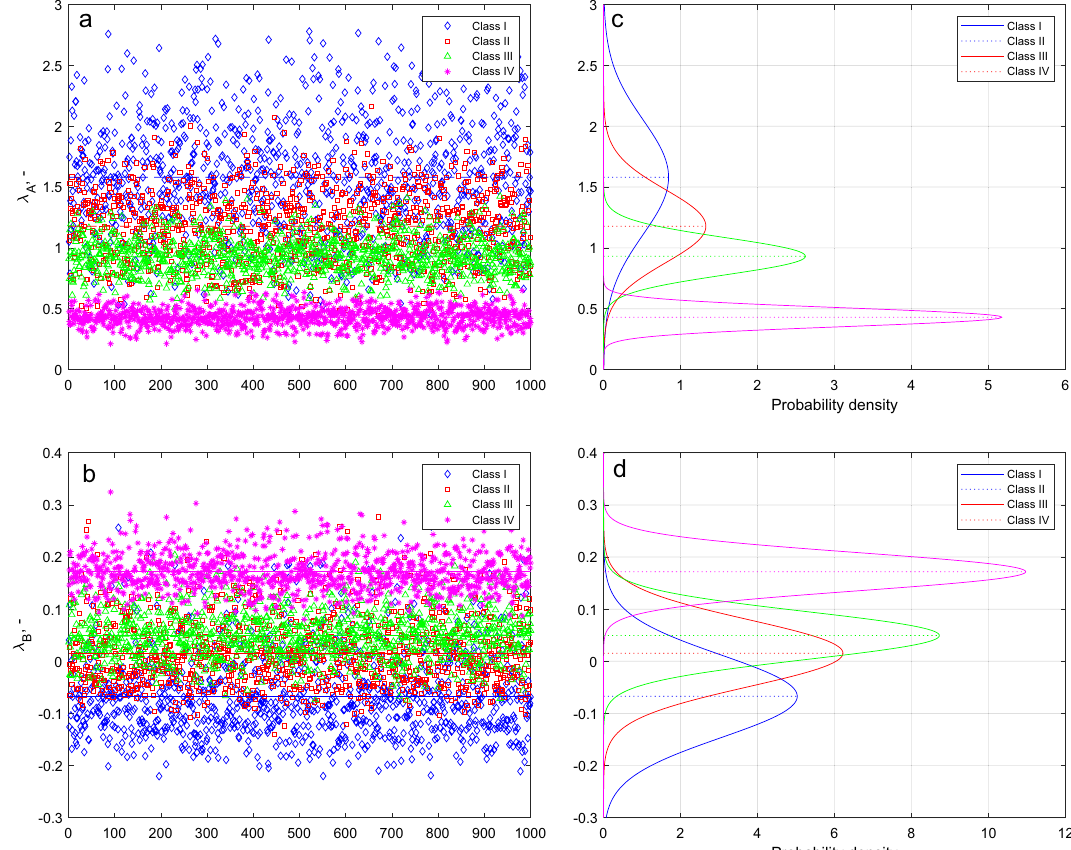
Figure 8. The values of parameters (cid:31) A ( a , upper left) and (cid:31) B ( b , lower left) are calculated from the power curves fitted to the randomly selected points. Random selection and determination of parameters were performed 1000 times. Figures 8c and 8d on the right respectively show the normal distribution fitted to the (cid:31) values.